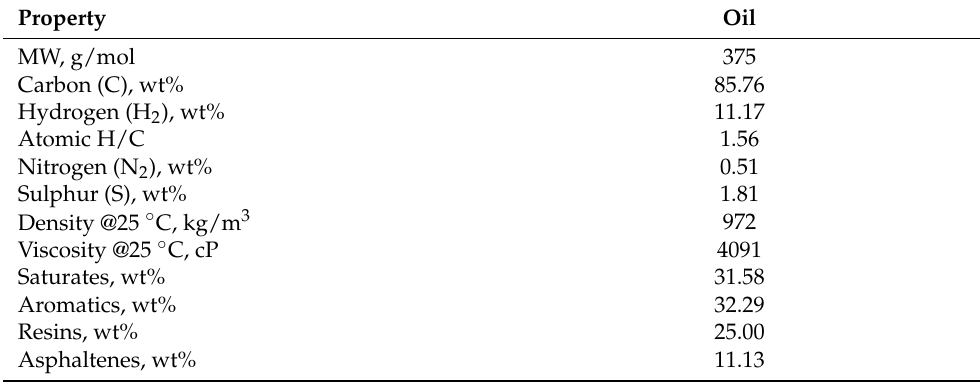
Table 1. Characteristics of the filtered heavy oil